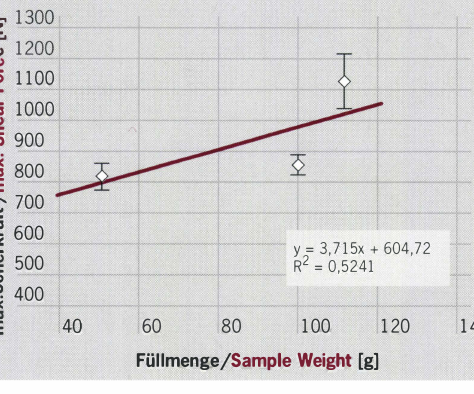
Fig. 6: Effect of sample weight (layered) on the maximum shear force (beans, n = 30)